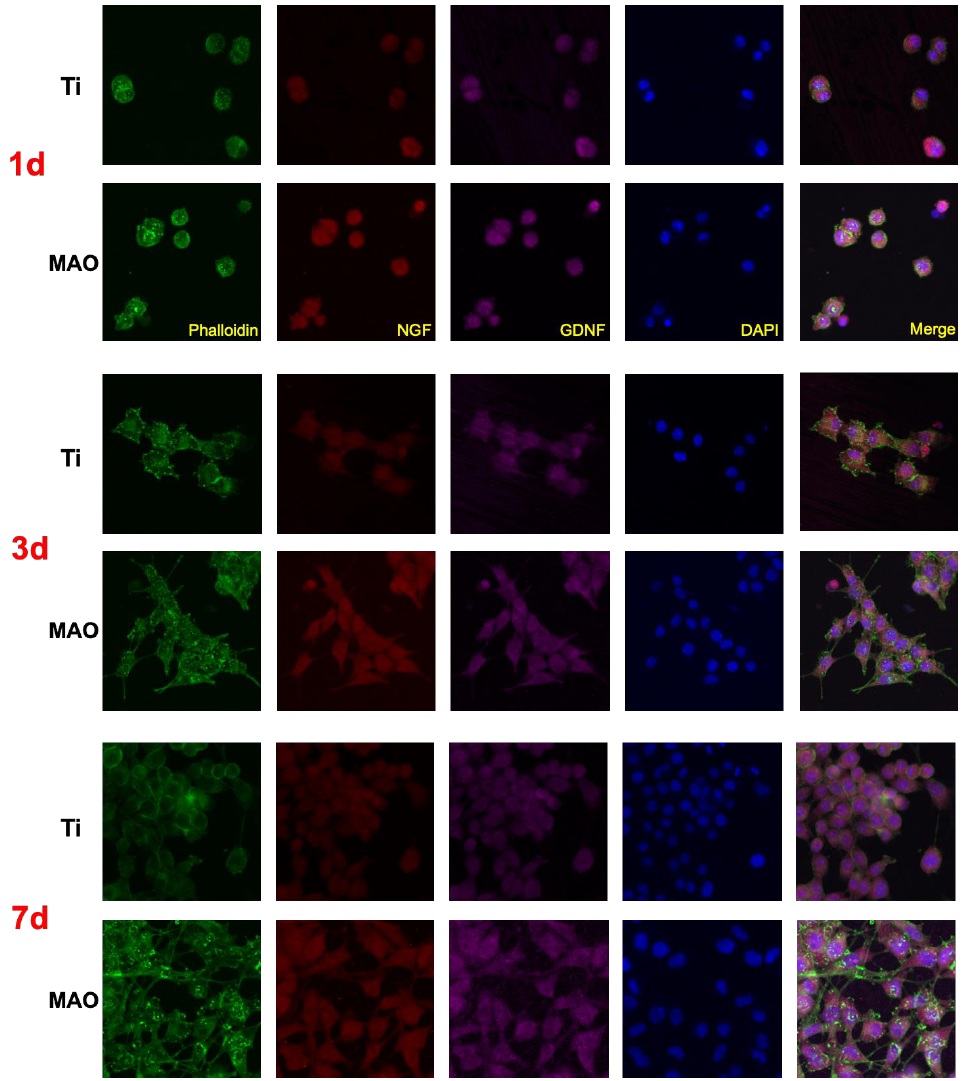
Figure 4. The morphology and expression of NGF and GDNF of Schwann cells on MAO and Ti surfaces on days 1, 3 and 7 of culture by CLSM.